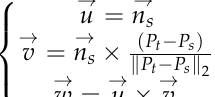
Figure 8. The relationship between two adjacent points.